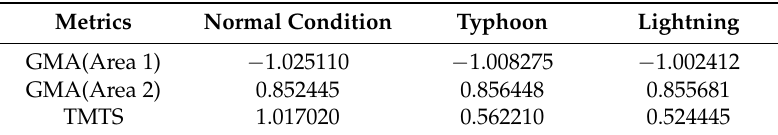
Table 2. Generation and transmission margins for toughness